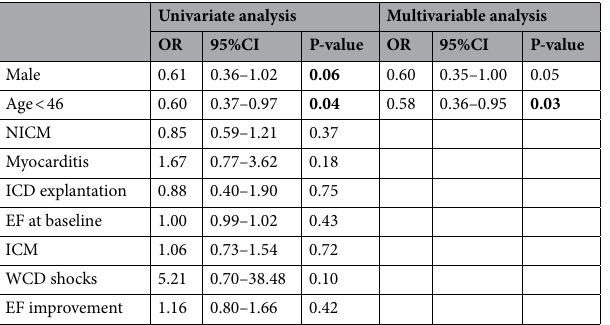
Table 6. Multivariable logistic regression analysis for the compliance. OR odds ratio, EF ejection fraction, NICM non-ischemic-cardiomyopathy, WCD wearable